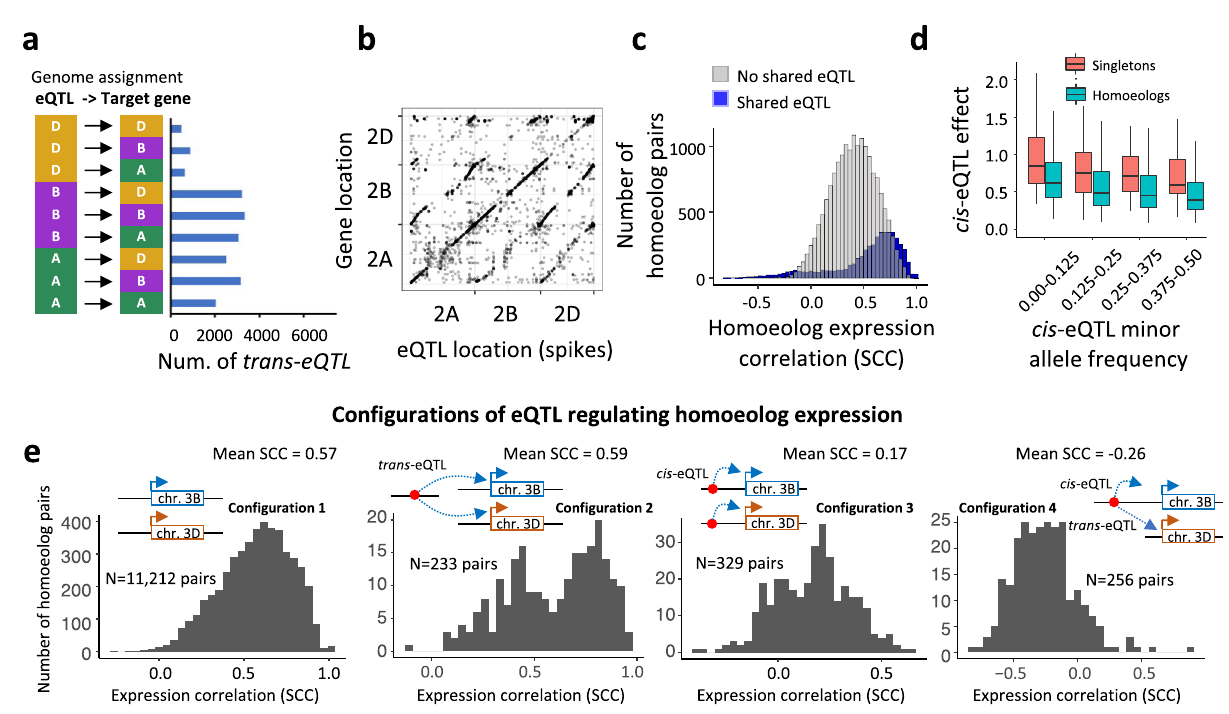
Fig. 4 Effects of cis - and trans -eQTL identi fi ed in wheat seedlings and spikes on homoeologous gene expression. a The total number of trans -eQTL targeting genes located either in the same genome (A → A, B → B, D → D) or in different genomes (A → B, A → D, B → A, B → D, D → A, D → B). b Location of eQTL relative to positions of target genes on wheat chromosomes 2A, 2B, and 2D in wheat spikes. c . Distribution of Spearman Correlation Coef fi cient (SCC) estimated for the pairs of homoeologs that either share at least one eQTL or do not share any eQTL. d The relationship between cis -eQTL minor allele frequency and effect size (absolute values) for two groups of genes, homoeologs, and singletons. Box shows the median and interquartile ranges (IQR). The end of the top line is the maximum or the third quartile (Q) + 1.5 × IQR. The end of the bottom line denotes either the minimum or the fi rst Q − 1.5 × IQR. e Distribution of expression correlation values between the pairs of homoeologs for various eQTL - target gene con fi gurations. A pair of homoeologs from chromosomes 3B and 3D was used to illustrate locations of cis - and trans -eQTL relative to their target genes. Source data are provided as a Source Data fi